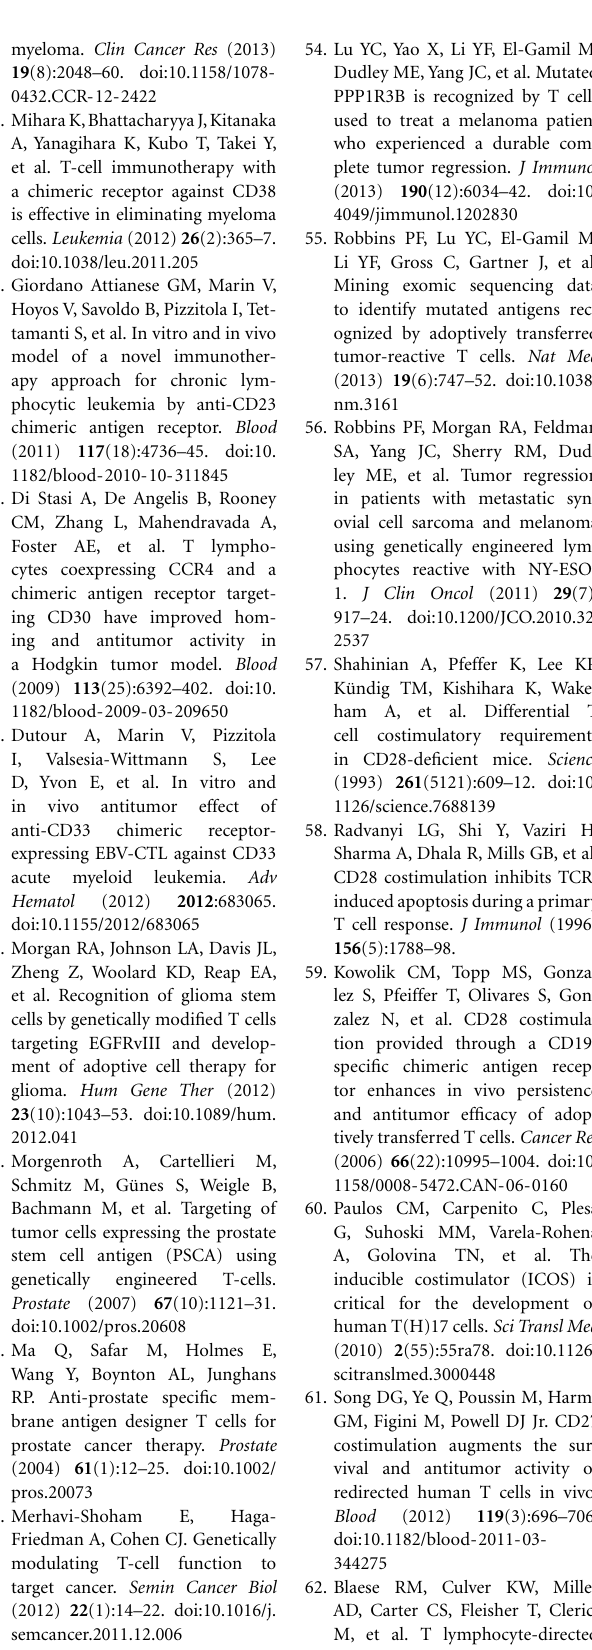
GM, Figini M, Powell DJ Jr. CD27 costimulation augments the sur- vival and antitumor activity of redirected human T cells in